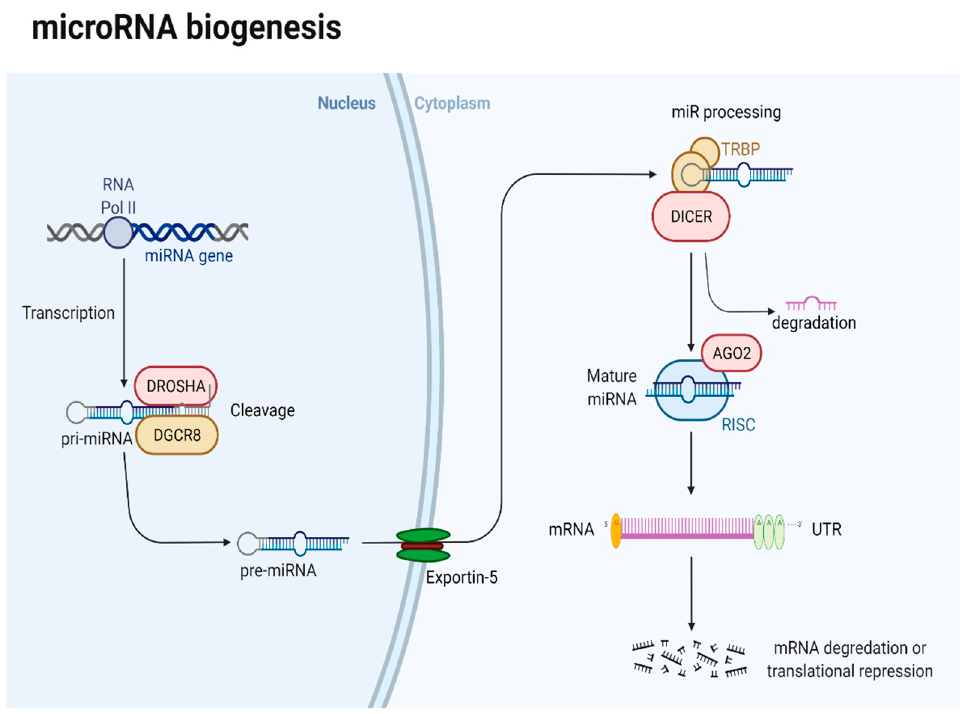
Figure 1. Schematic illustration of microRNA biogenesis.